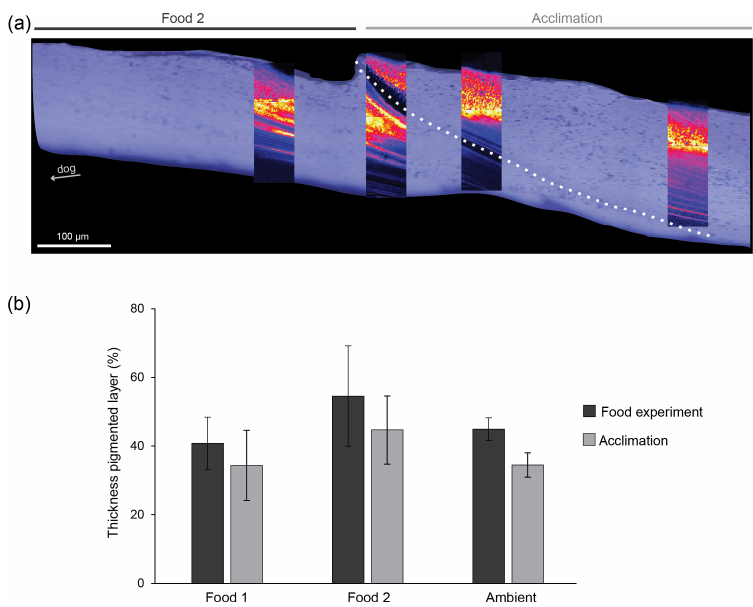
Figure 9. Effects of diet on shell pigment distribution. (a) Raman spectral maps of the 1524cm − 1 band representing the distribution of the polyenes in the shell cultured with food type 2. Dotted line marks the start of the experiment; dog is direction of growth. (b) The graph shows the thickness of the pigmented layer over the whole shell thickness before and during the food